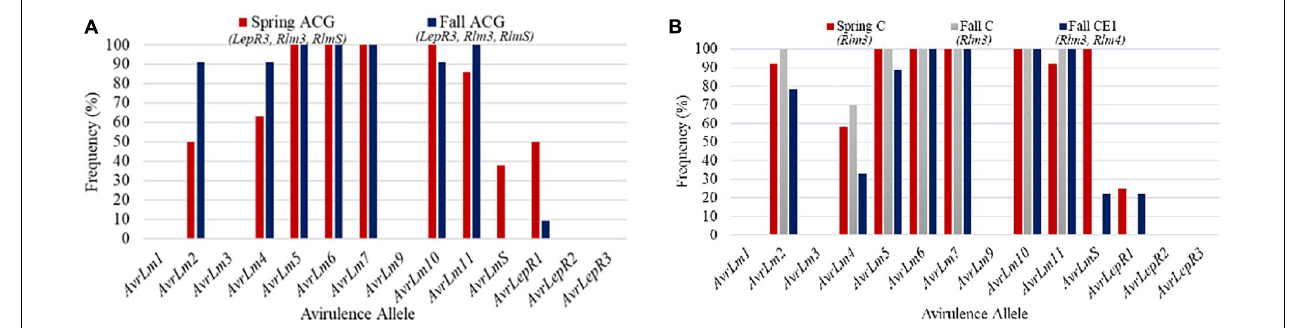
FIGURE 6 | The frequency of avirulence alleles in the Leptosphaeria maculans population from 20 isolates collected in the spring and fall from field site MB5 in Manitoba from 2018 with a cultivar containing ACG (A) . The frequency of avirulence alleles in the Leptosphaeria maculans population from 30 isolates collected in the spring and fall from field site MB6 in Manitoba from 2018. The field site had two cultivars grown with different resistance gene groups, cultivars with C and CE 1 (B)